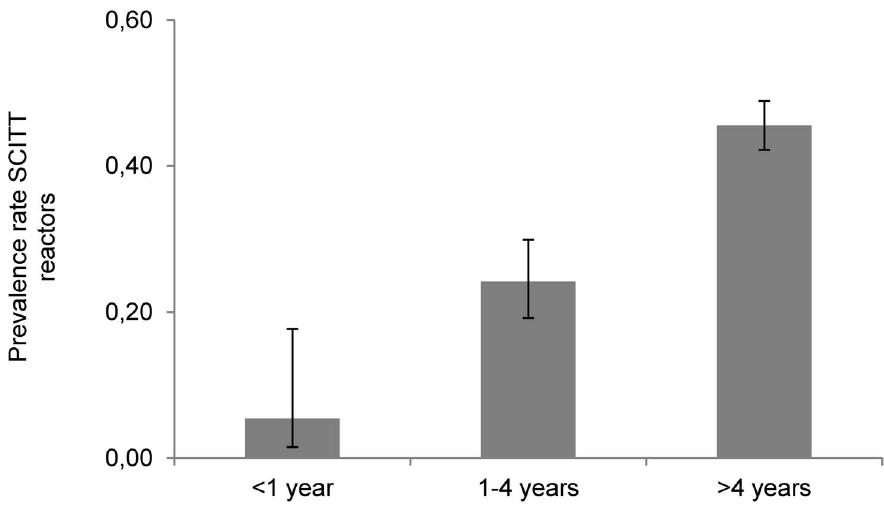
Figure 2. Prevalence rates among SICTT reactors (95% confidence intervals) by age classes.